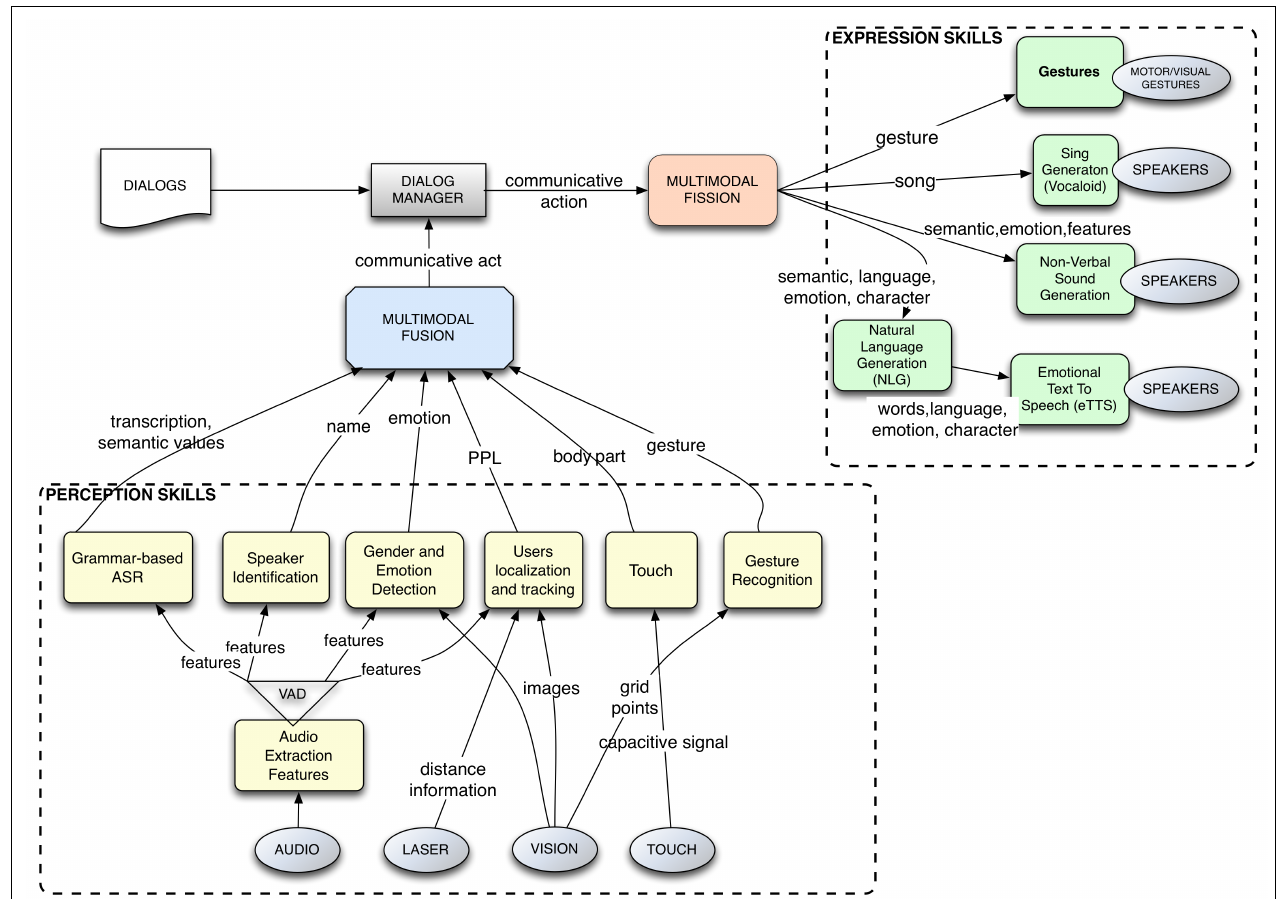
Figure 2. Sketch of the main components of the robotic dialog system: perception skills